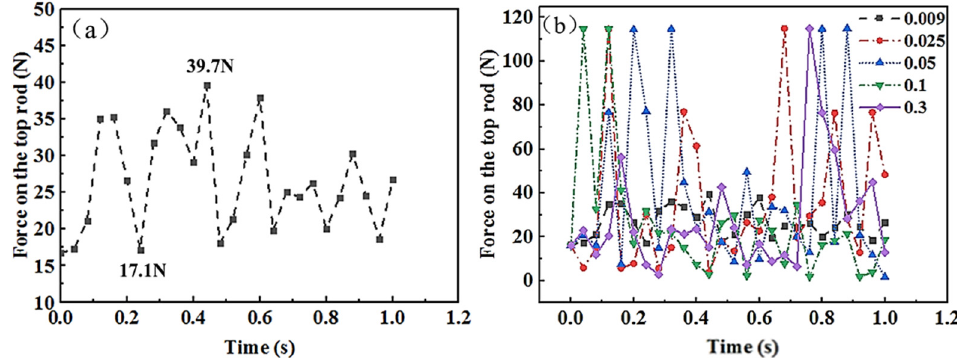
Figure 10. Force diagram of top rod with ( a ) a friction coefficient of 0.009 and ( b ) different friction coefficients.